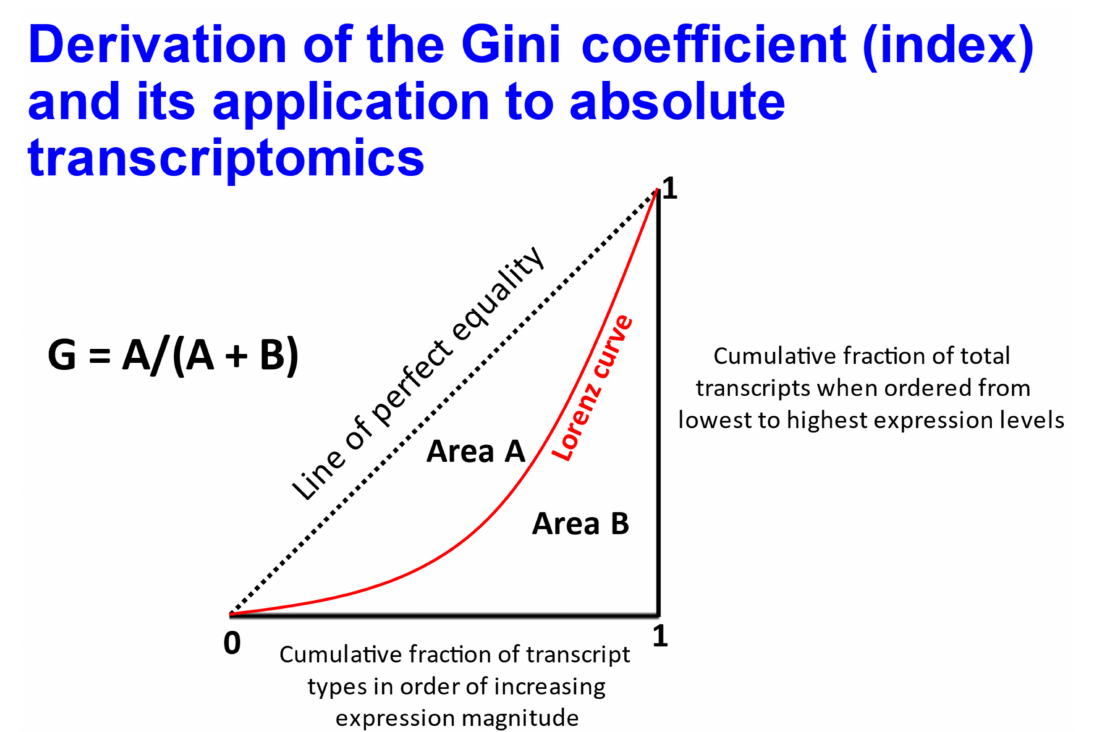
Figure 8. Illustration of the derivation of the non-parametric Gini coefficient for describing the inequality of a distribution (here the variation of transcript levels between cell lines). This was achieved by rank ordering the value of the different examples according to their expression levels, as indicated.